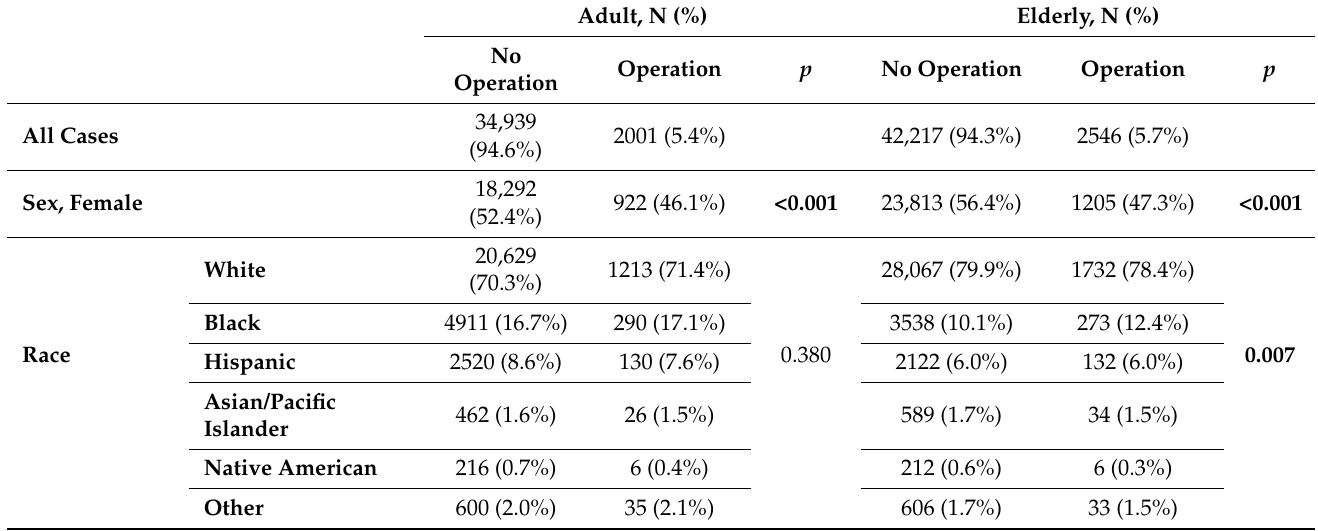
Table 4. Characteristics of emergency-admitted patients with the primary diagnosis of paralytic ileus (NIS 2005–2014). Data are stratified according to operation